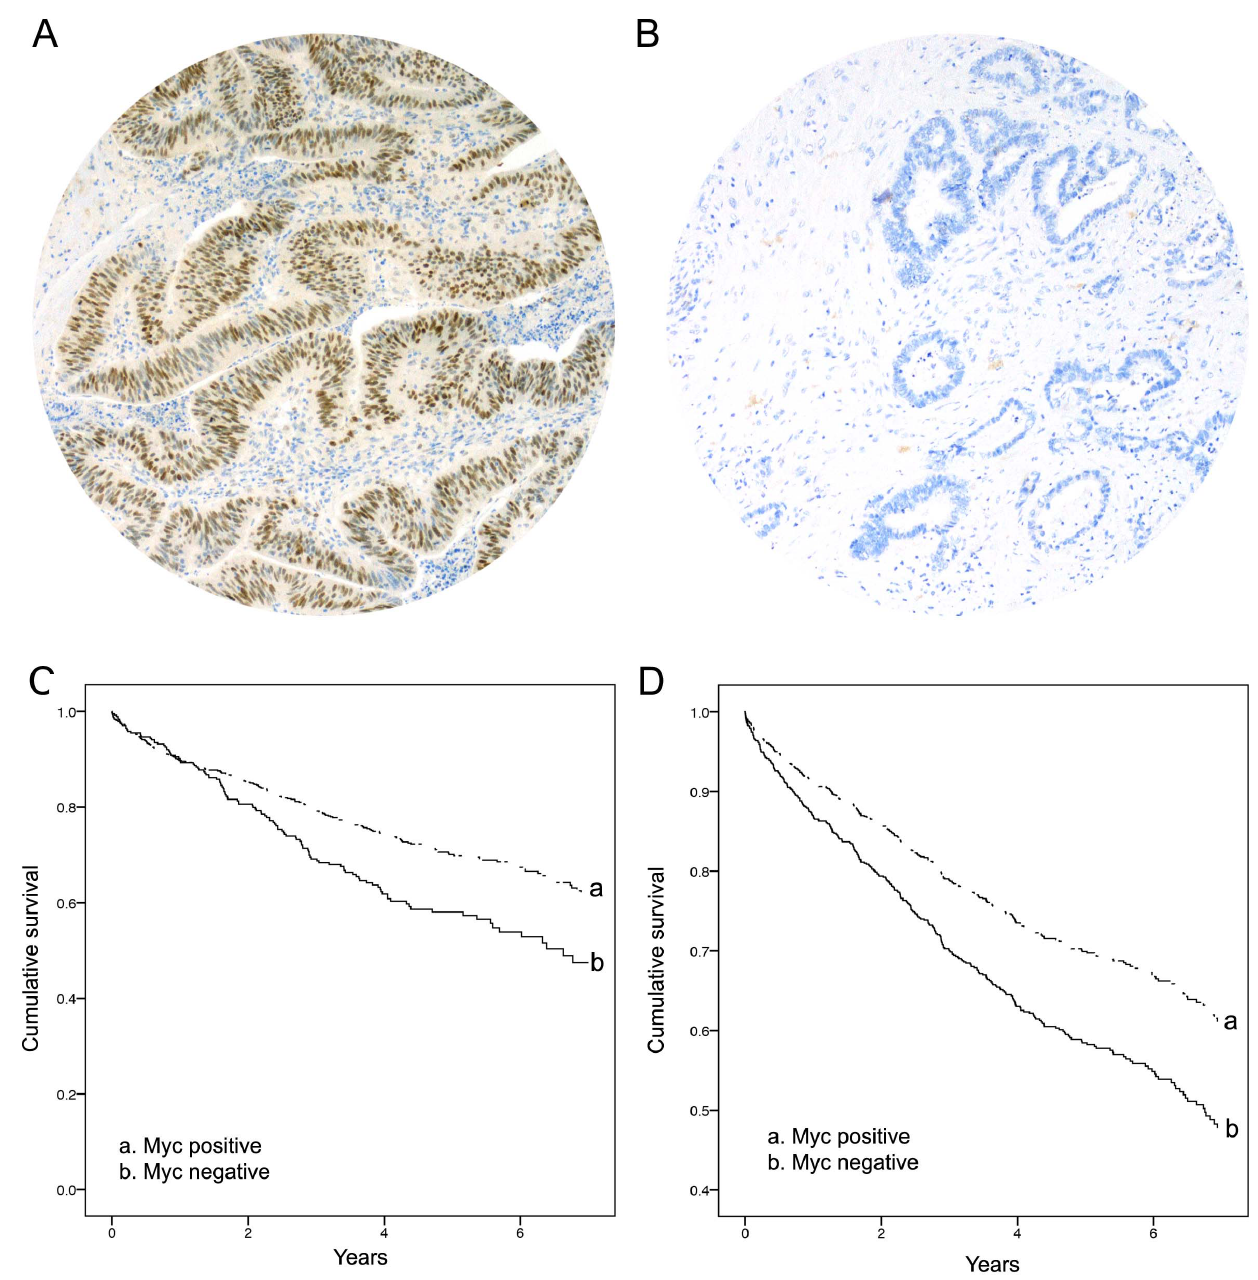
Figure 1. Panel A: Myc positive IHC staining; Panel B: Myc negative IHC staining; Panel C: Kaplan Meier analysis (Log Rank test p=0.01); Panel D: Univariable Cox regression.